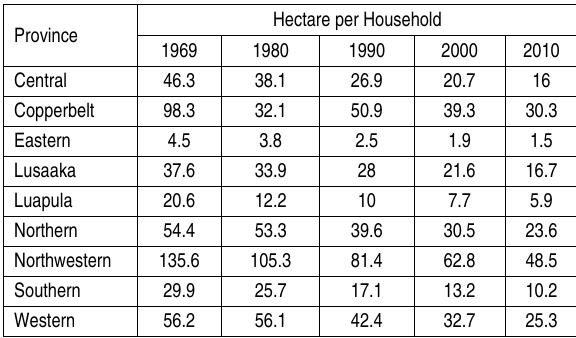
Table 2. Customary land available per